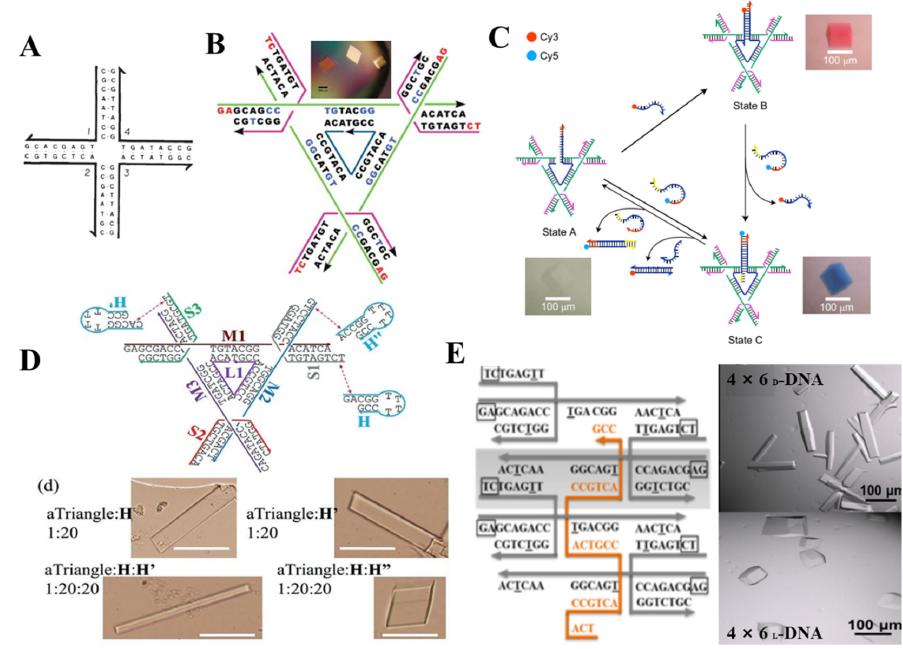
Figure 4. 3D superlattice via DNA tile connection. ( A ) four-arm junction; (Adapted with permission from [33]. Copyright 1983, Springer Nature). ( B ) Design of tensegrity triangle as building block and the corresponding assembly, (Adapted with permission from [38]. Copyright 2009, Springer Nature.); ( C ) Three-state 3D device composed of 3D crystalline lattice and dynamic device (Adapted with permission from [39]. Copyright 2017, Springer Nature.); growth modulation for 3D lattice by agent strand in triangle motif ( D ) (Adapted with permission from [40]. Copyright 2018, WILEY − VCH Verlag GmbH & Co. KGaA, Weinheim, Germany). A weaving strand in 4 × 5 motif ( E ) (Adapted with permission from [41]. Copyright 2017, American Chemical